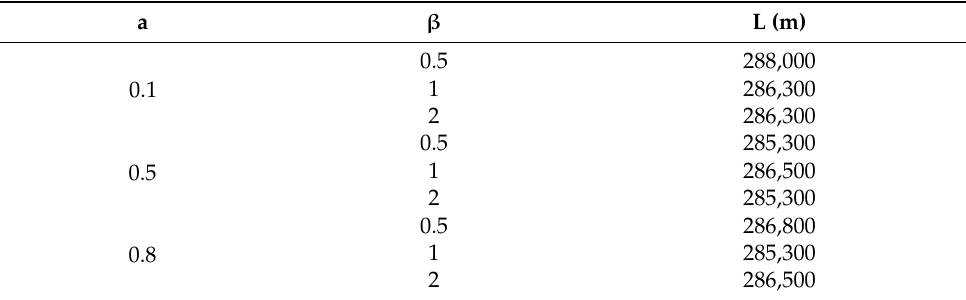
Table 2. Objective function values for different a and β combinations.